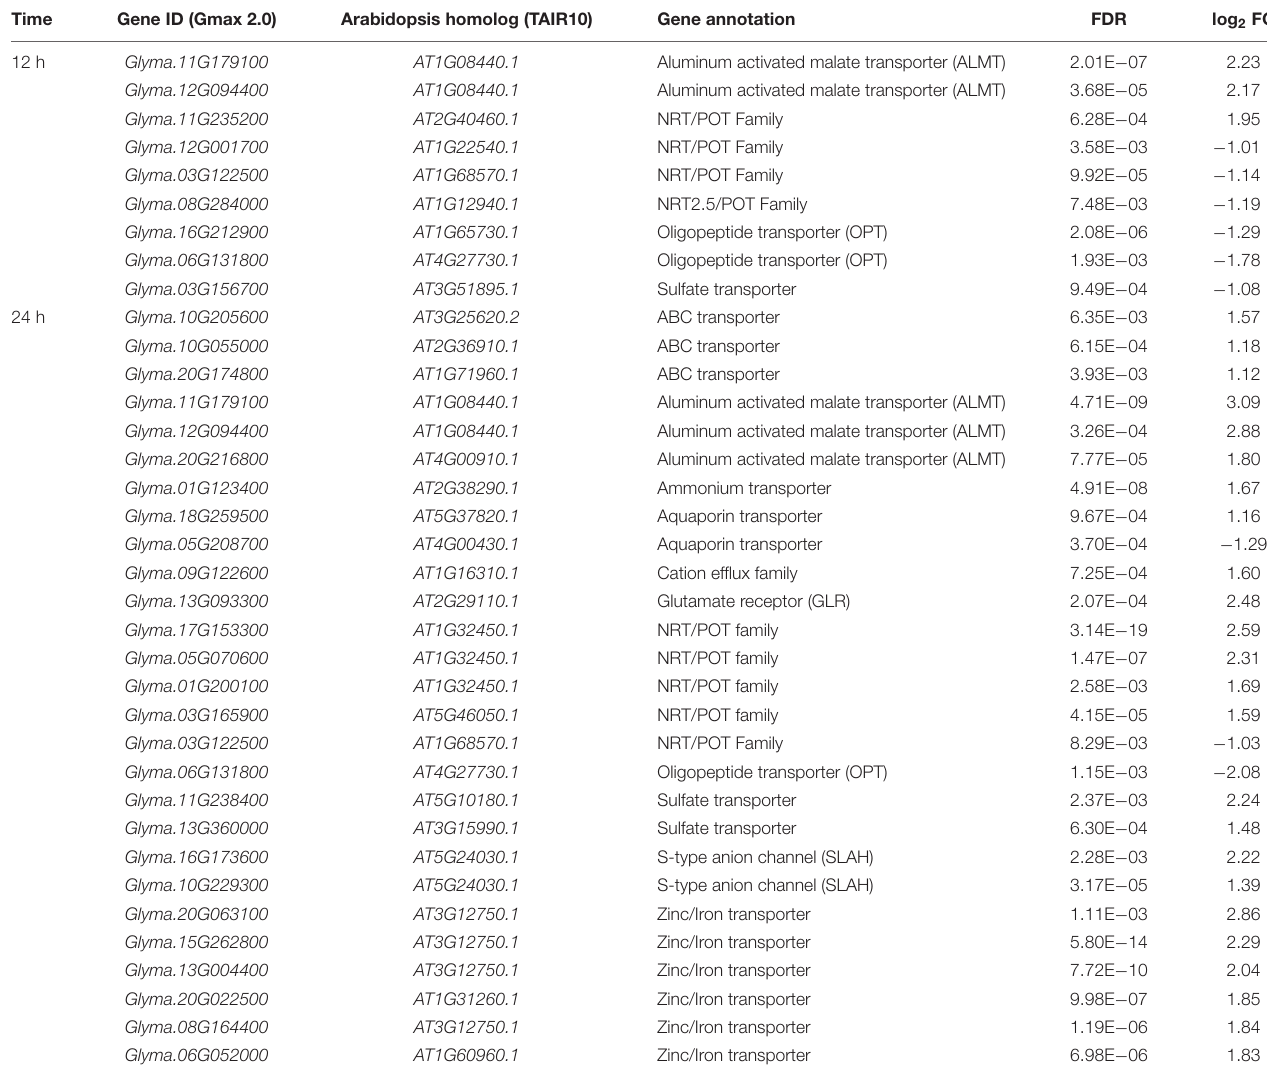
TABLE 1 | Transport related differentially expressed genes between NaHCO 3 treatment and control in the roots of wild soybean N24852. Time Gene ID (Gmax 2.0)